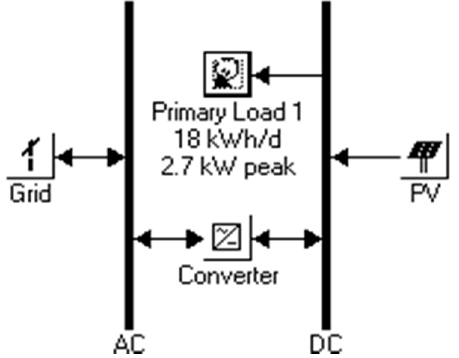
Figure 6. Model implemented in HOMER.